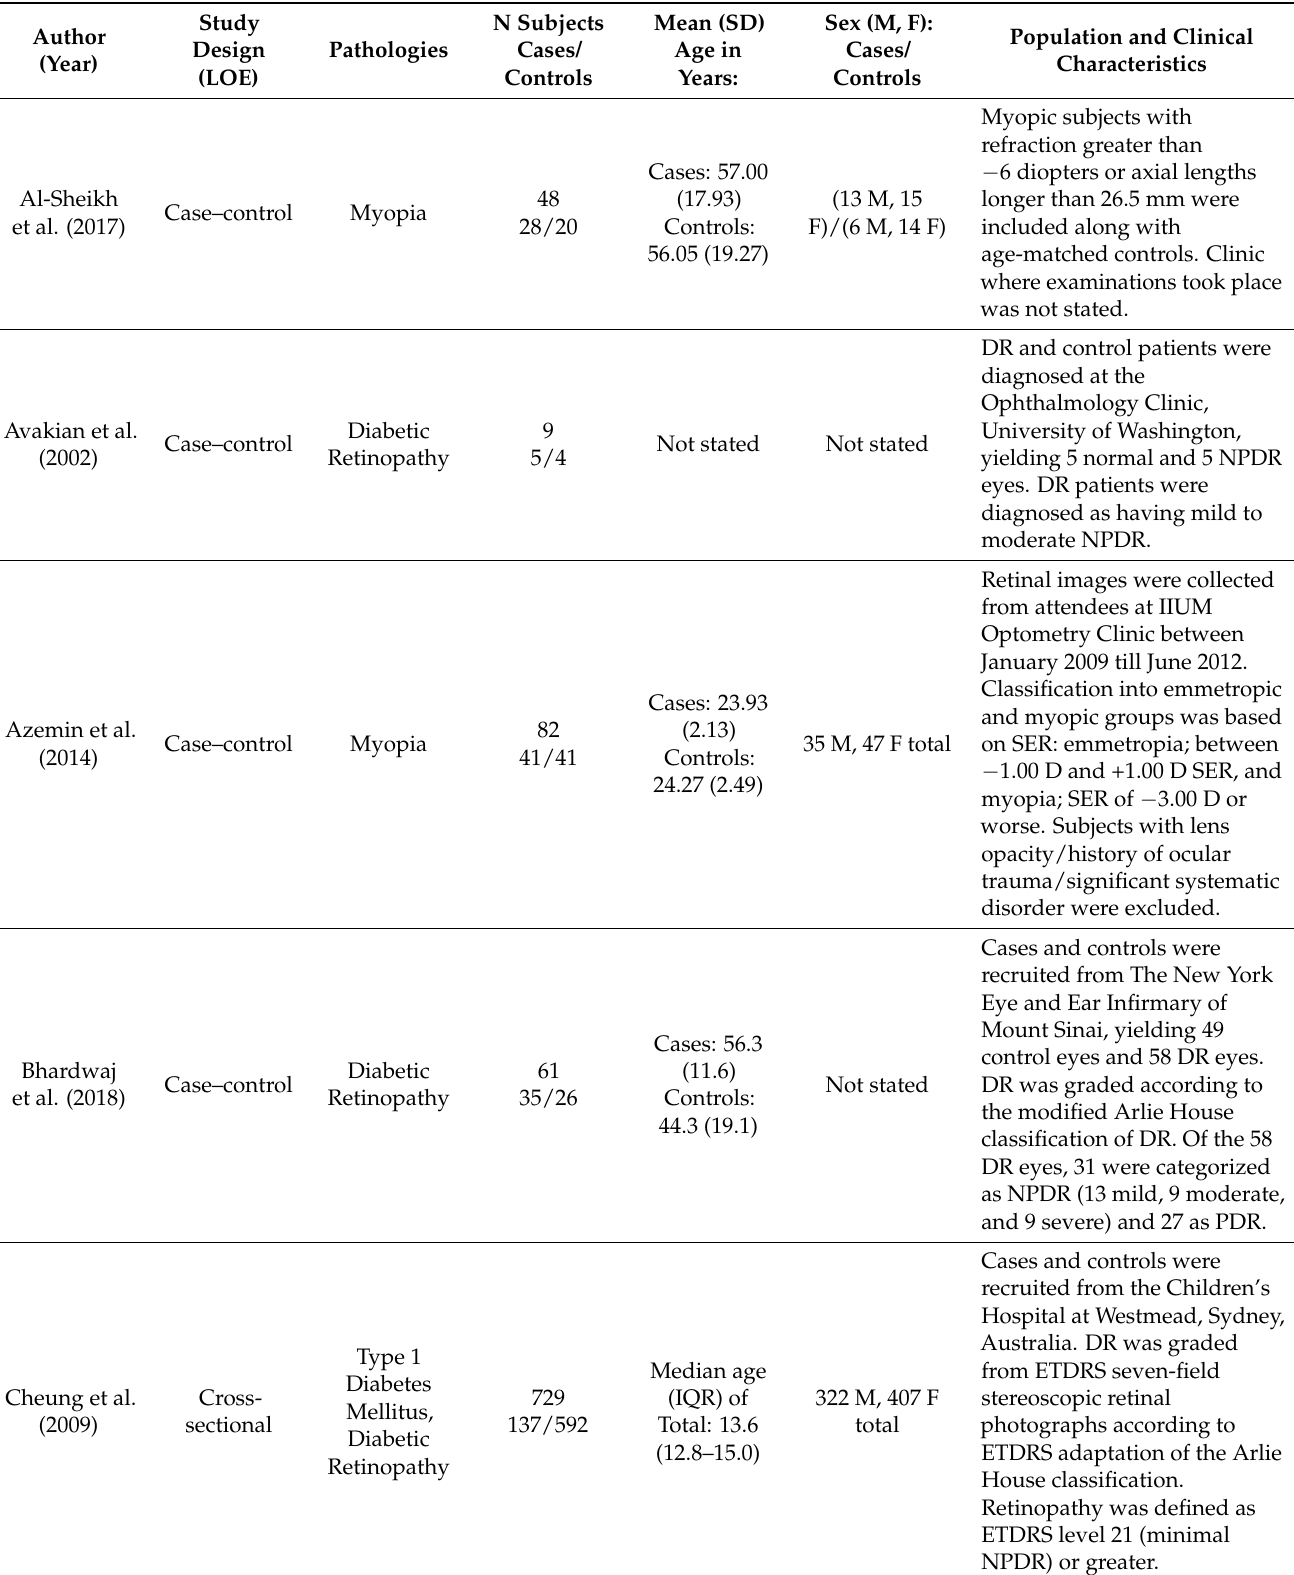
Table 2. Demographic information and clinical characteristics of study